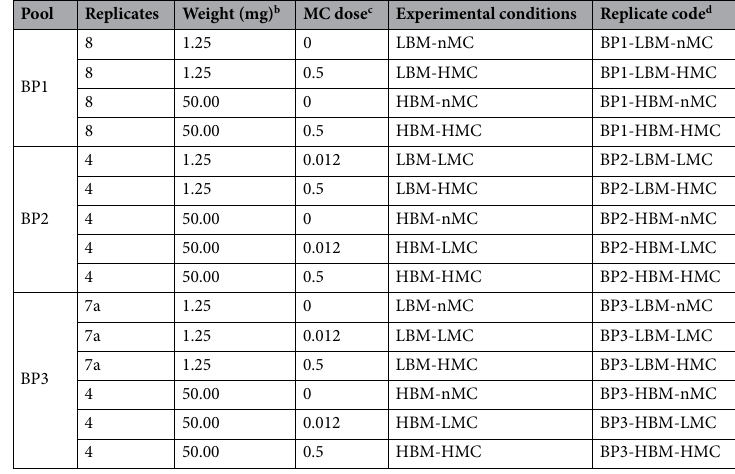
Table 1. Summary of sample codes and characteristics. For each Pool (BP1, BP2, BP3 n = 3), the sample weight, mock community dose and number of technical replicates are reported. a 4 technical and 3 biological replicates. b Low biomass (LBM) correspond to 1.25 mg of pooled bovine fecal sample; High Biomass (HBM) correspond to 50 mg of pooled bovine fecal sample. c Fraction of the recommended dose. One dose (20 μl) includes 2 × 10 7 cells of each of the two bacteria. d Amplicon libraries were named by concatenating information for the pool (BP1, BP2, BP3), the sample biomass (LBM: 1.25 mg, HBM: 50.00 mg), the MC dose (nMC: no MC added, LMC: 0.0125 dose, HMC: 0.5 dose).